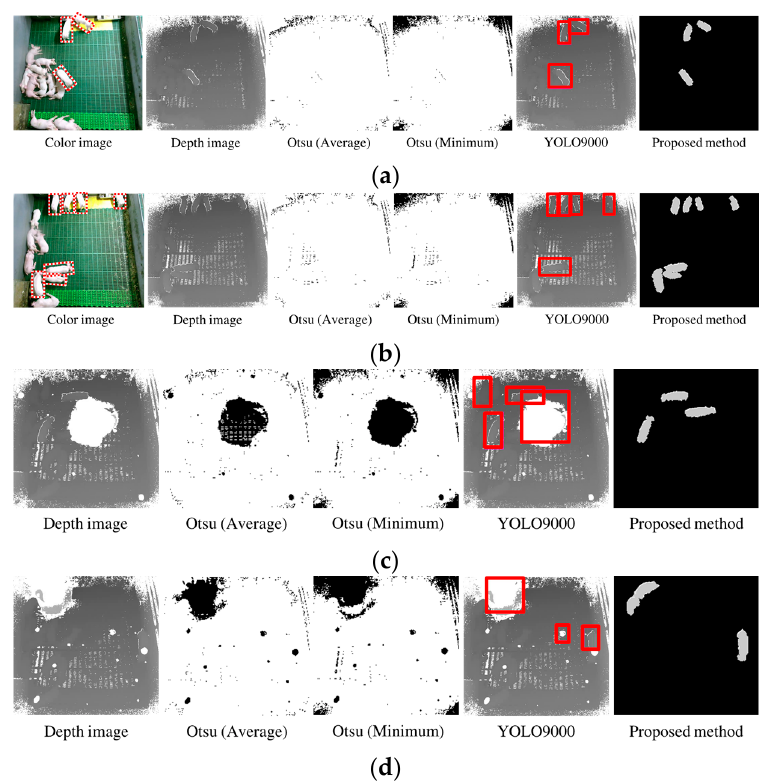
Figure 14. Results of each method for detecting standing-pigs: ( a , b ) results during daytime; and ( c , d ) results during nighttime. Because the light was turned off, corresponding color images are not shown during nighttime.